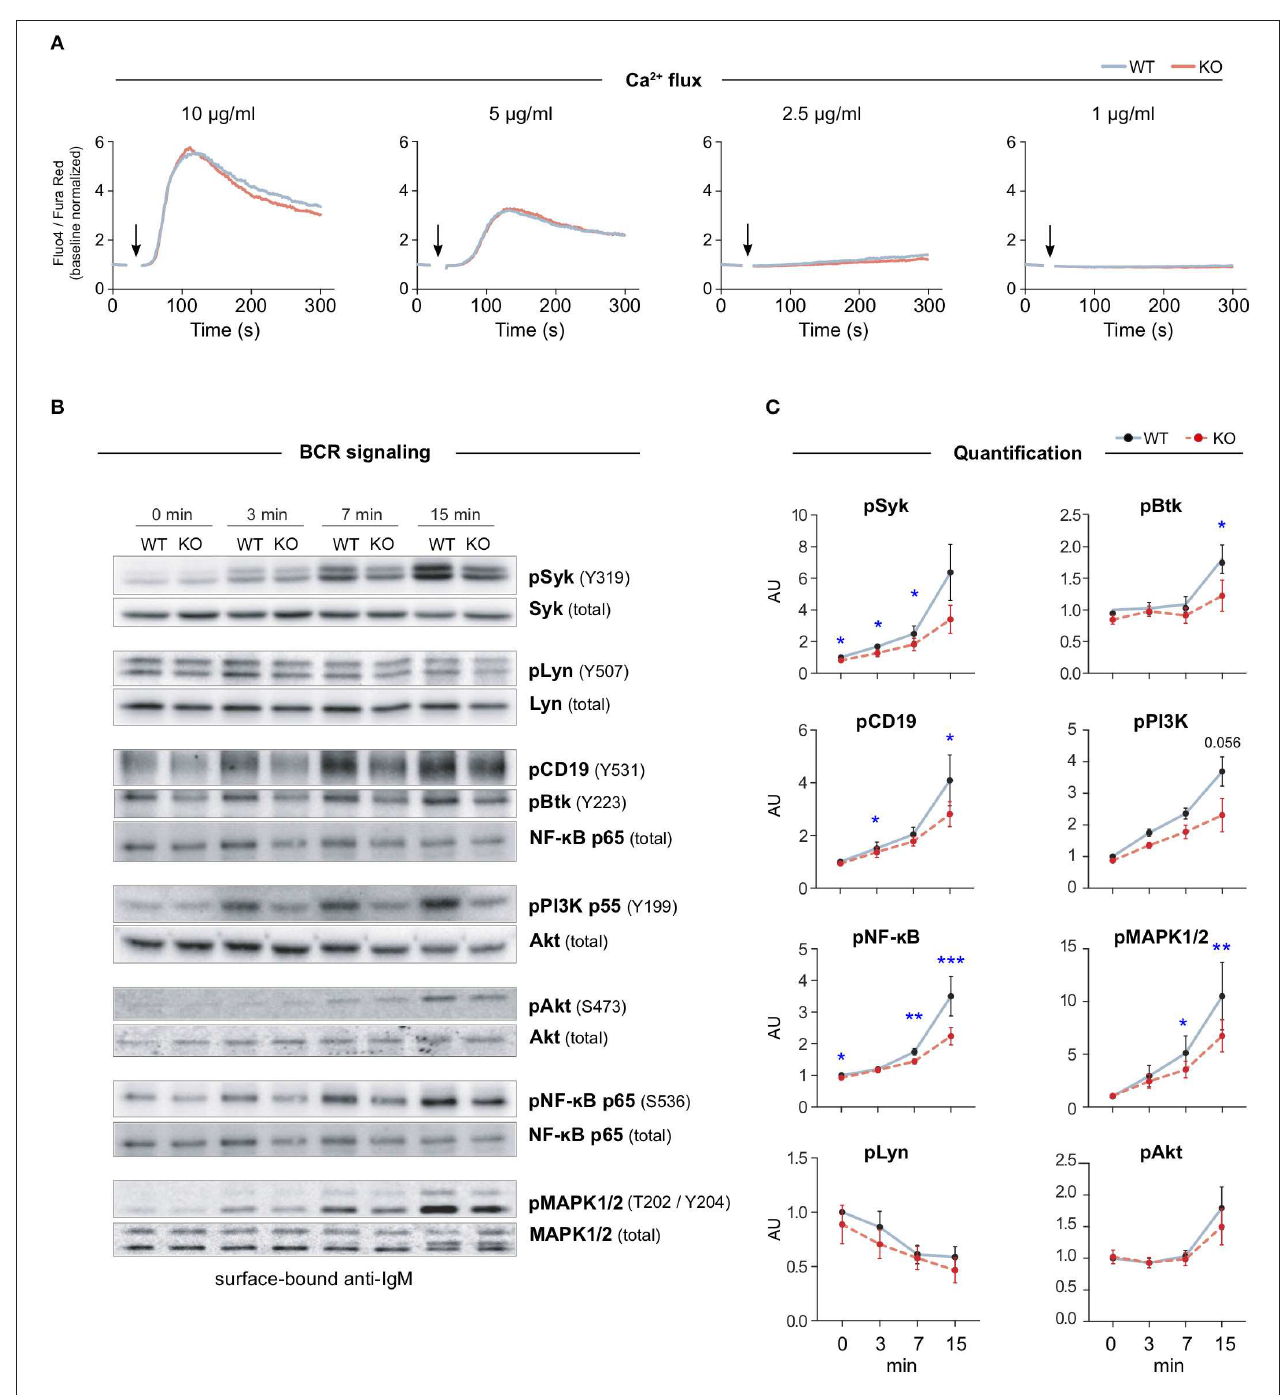
FIGURE 2 | MIM deficiency leads to impaired B cell receptor signaling in response to surface-bound antigen. (A) Flow cytometry analysis of Ca 2 + mobilization in response to BCR stimulation in solution. Splenic B cells from WT or MIM-KO mice were labeled with Fluo-4 and Fura Red and stimulated with 10, 5, 2.5, or 1 µ g/ml anti-IgM antibodies. Time of anti-IgM antibody addition is indicated by an arrow. Data are presented as a ratio of Fluo-4 to Fura Red median fluorescence intensity. Mean values of three to five independent experiments are shown. (B) Splenic B cells were stimulated on surfaces coated with 5 µ g/ml anti-IgM antibodies for 0, 3, 7, and 15min and lysed. Lysates were subjected for immunoblotting for phosphorylated forms of different BCR signaling effector proteins. Unphosphorylated forms of the corresponding proteins were used as loading control, except for pCD19, pBtk, and pPI3K, where NF- κ B p65, Syk or Akt were used as loading controls. (C) Quantification of the data in (B) . Data are presented as ratios of phosphorylated forms to total protein levels and normalized to the level of WT at 0min. Data are from four to eight independent experiments. Mean ± SEM is shown. * p < 0.05, ** p < 0.01, *** p < 0.001.